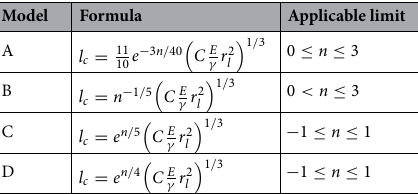
Table 3. Simplified formulas for critical height.